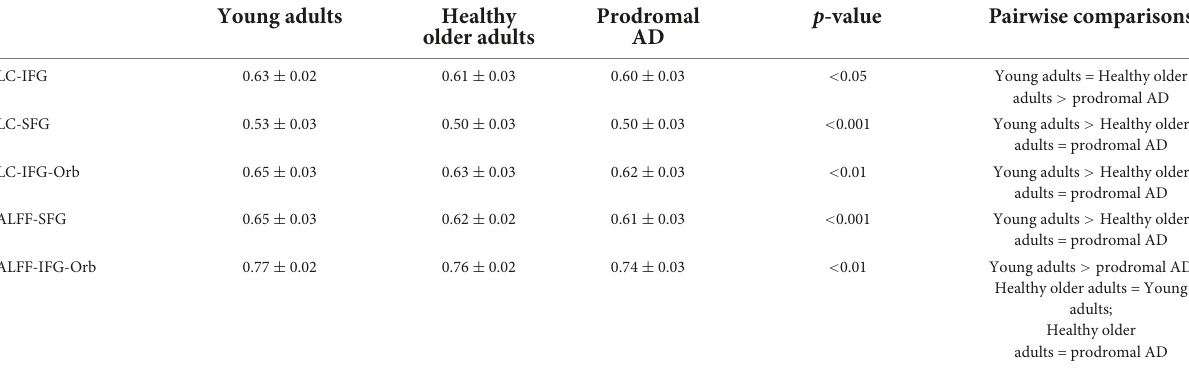
TABLE 4 Inter-group differences for integrated local correlation (ILC) and Fractional amplitude of low-frequency oscillation (fALFF). Young